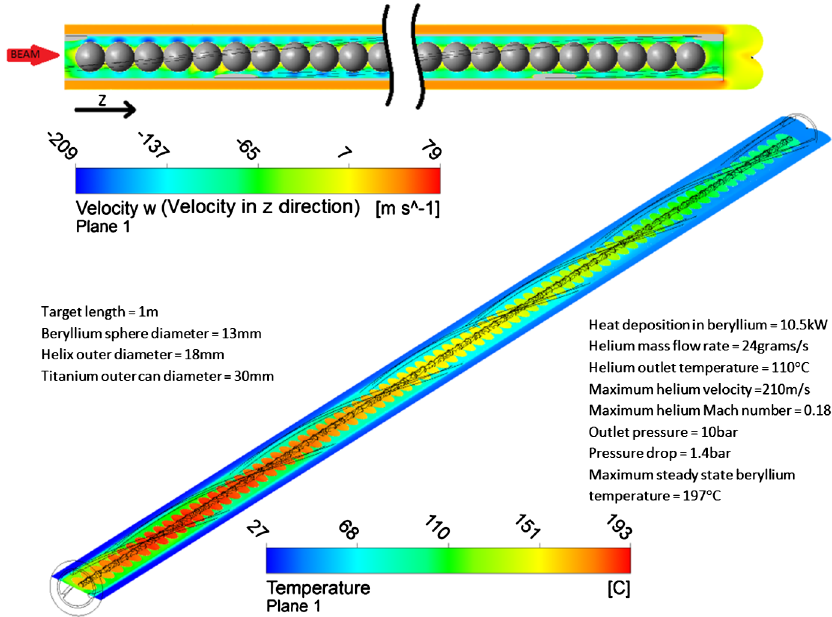
FIG. 9. Contour plots from steady state CFD simulations of a beryllium sphere target showing helium velocity and beryllium temperature.